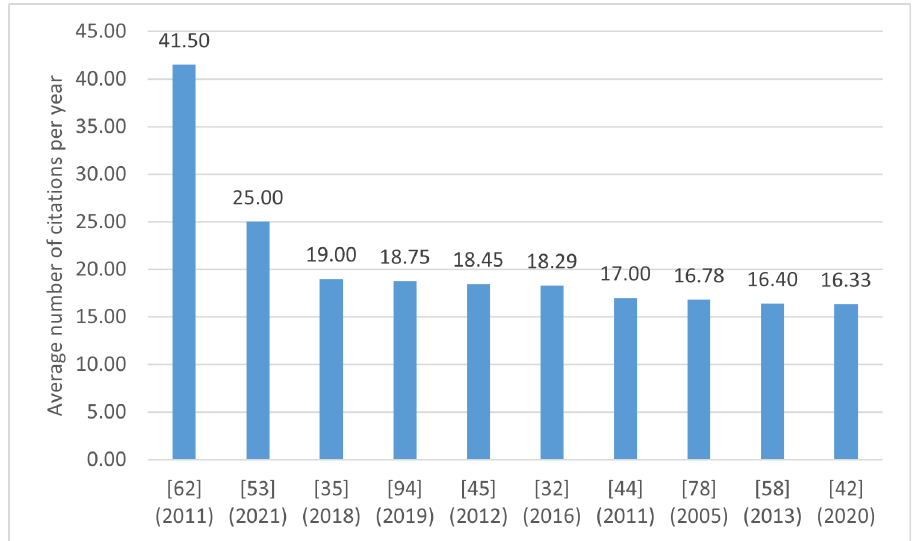
Figure 4. Top ten articles about MADM methods in AM based on average number of